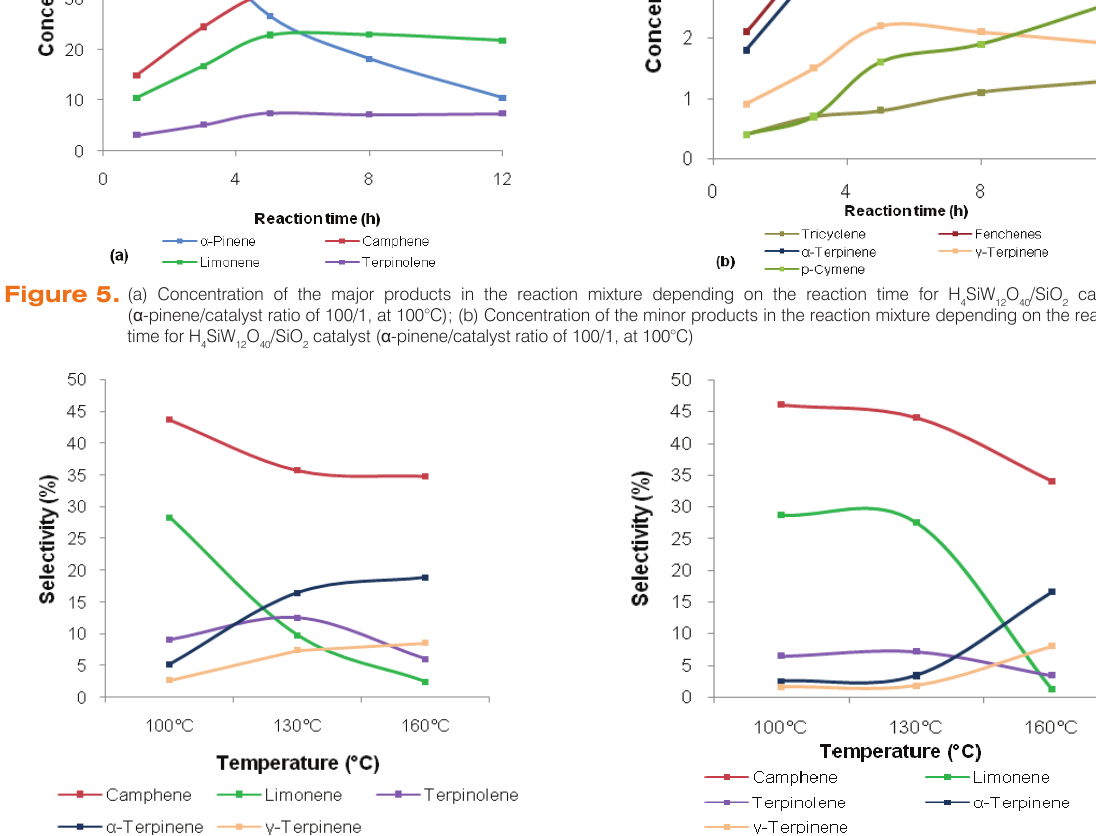
Figure 6. Effect of the reaction temperature on the selectivity of camphene, limonene and terpinolene ( α -pinene/catalyst: